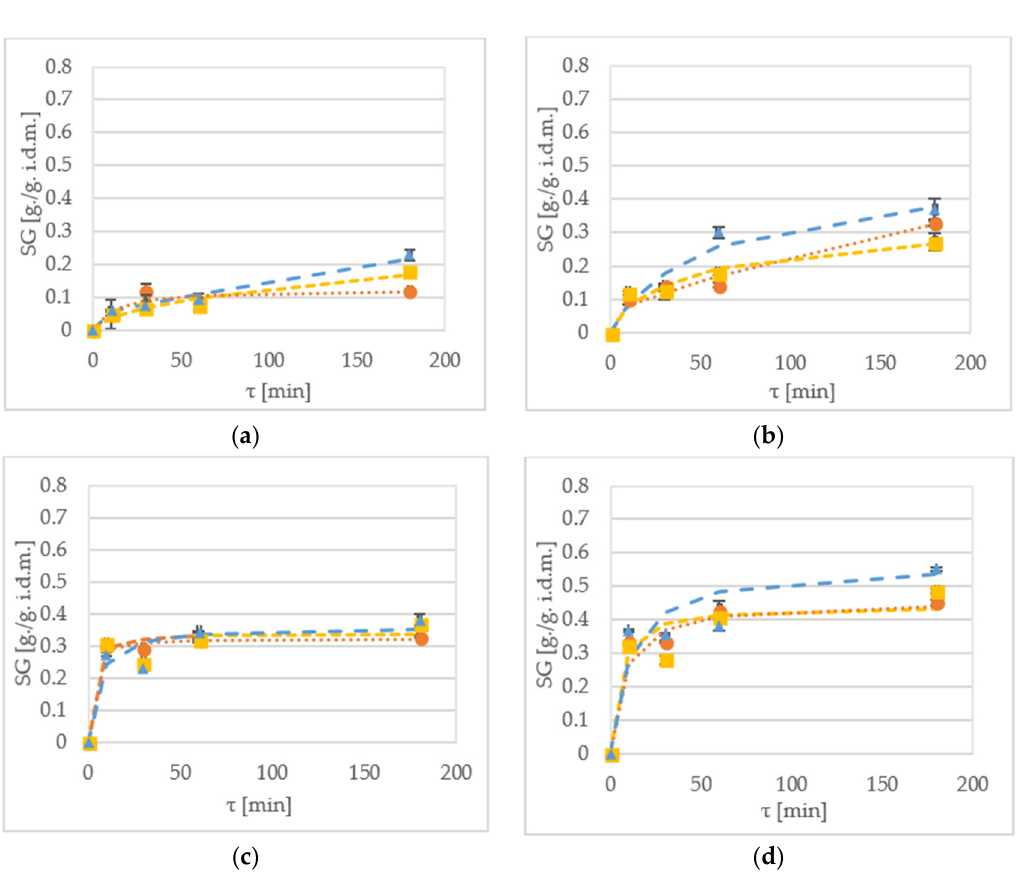
Figure 3. SG kinetics of the ‘Geneva’ cultivar dehydrated at ( a ) 30 °C; and ( b ) 50 °C in xylitol ( ▲ —triangle), maltitol ( ■ —square) and sucrose ( ● —circle). SG kinetics of. the ‘Weiki’ cultivar dehydrated at ( c ) 30 °C and ( d ) 50 °C in xylitol ( ▲ —triangle), maltitol ( ■ —square) and sucrose ( ● —circle). Dotted lines represent values obtained from the mathematical modelling.